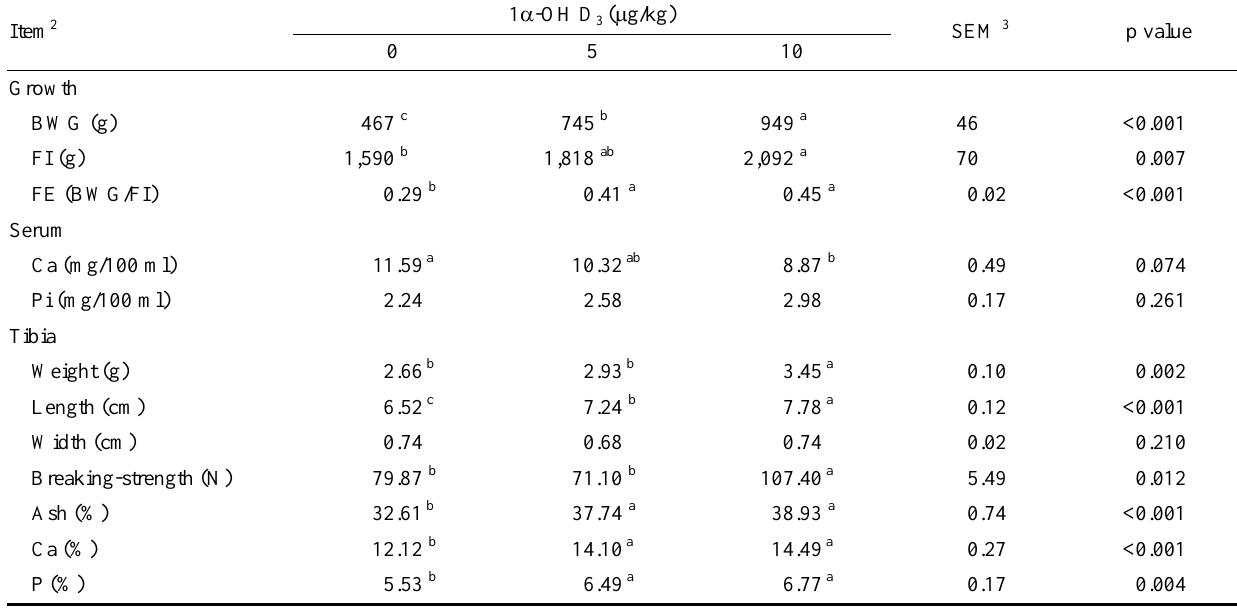
Table 2. Effect of 1  -OH D 3 on growth performance, serum minerals, and tibia qualities of 21- to 42-d-old broilers 1